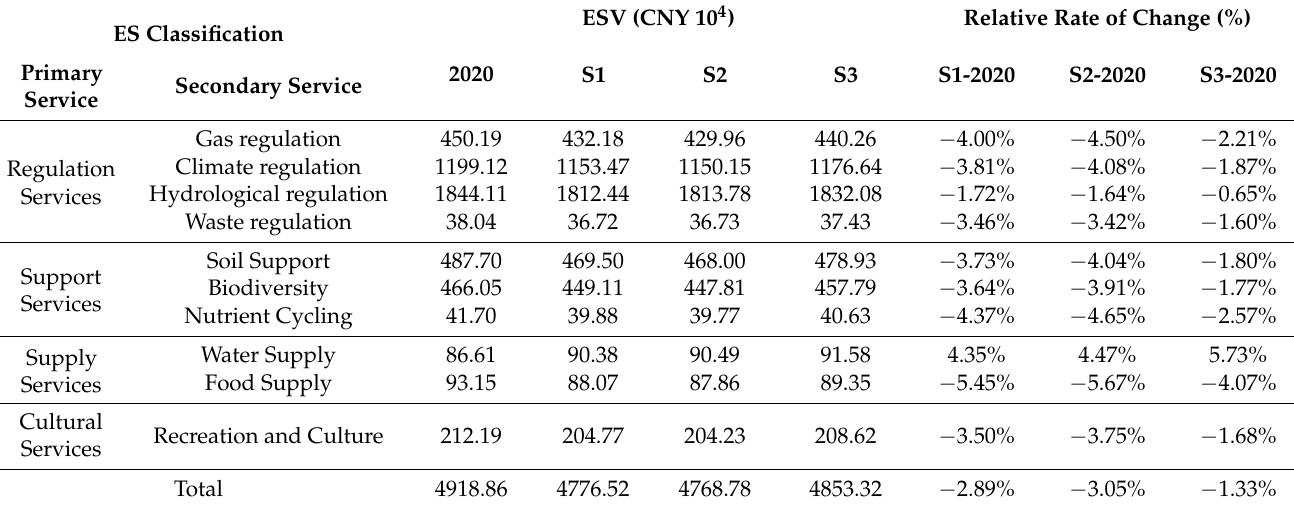
Table 6. Changes in ESVs of the GHM-GBA under three